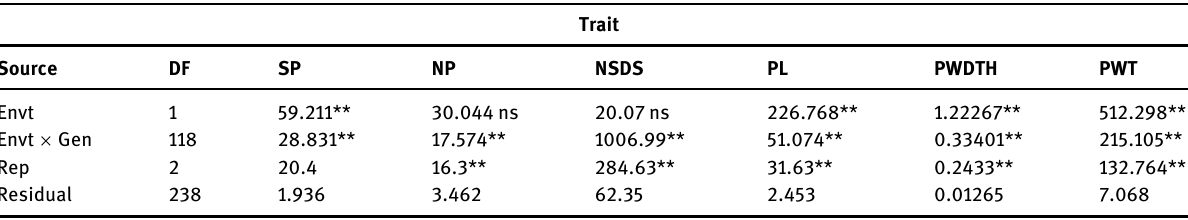
Table 3: Mean square of yield - related traits from the analysis of variance from two screen houses for 60 cowpea accessions after drought